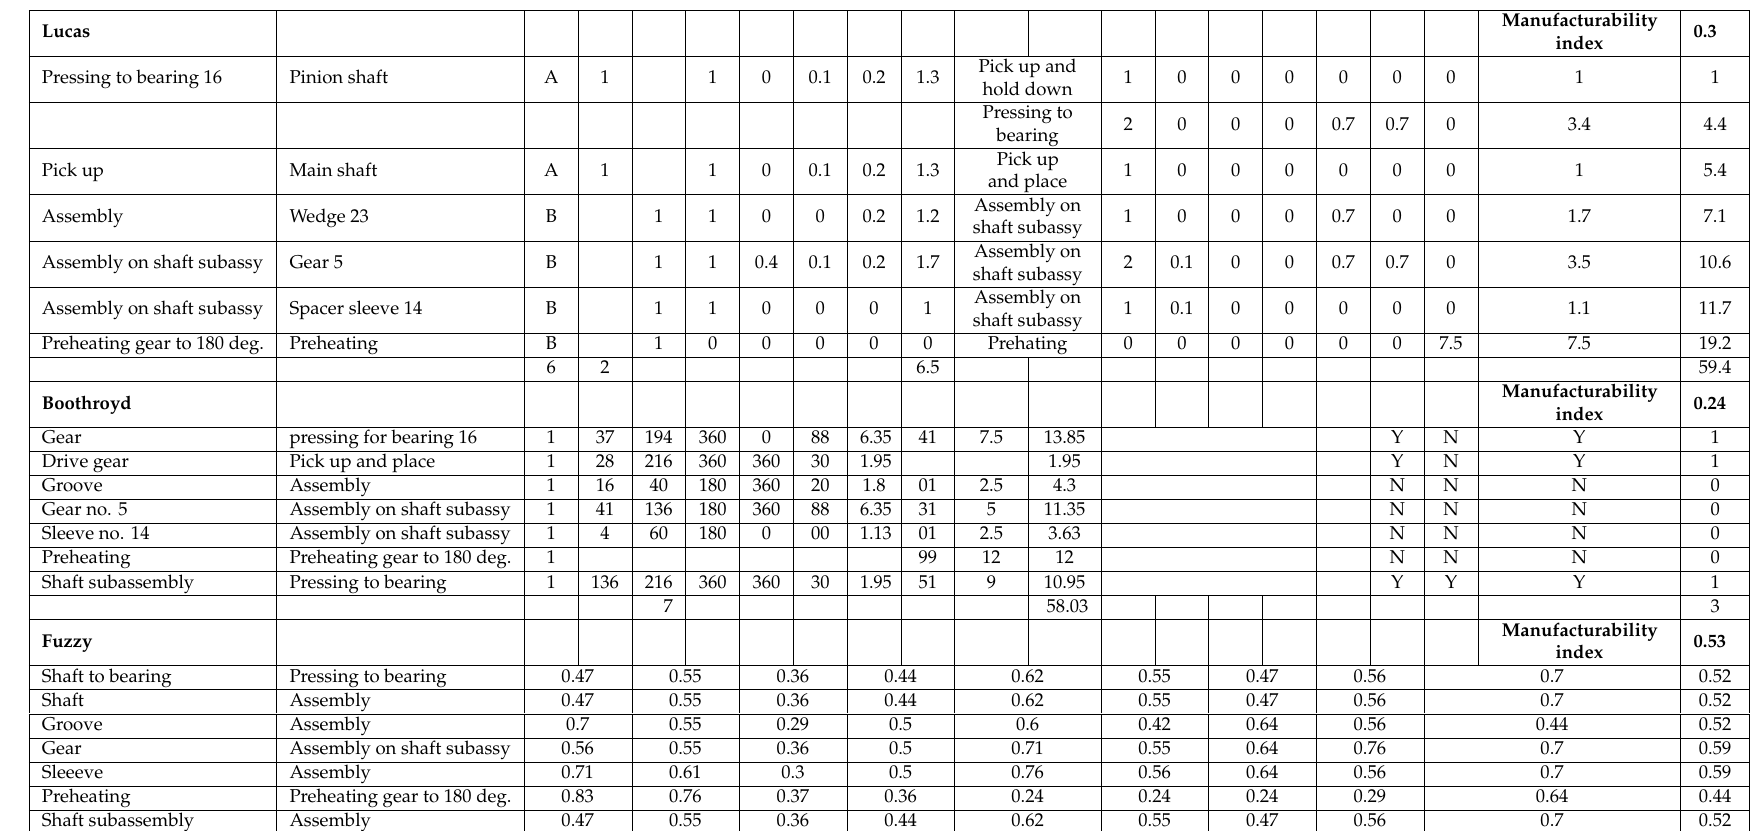
Table 15. Comparison of methods design for